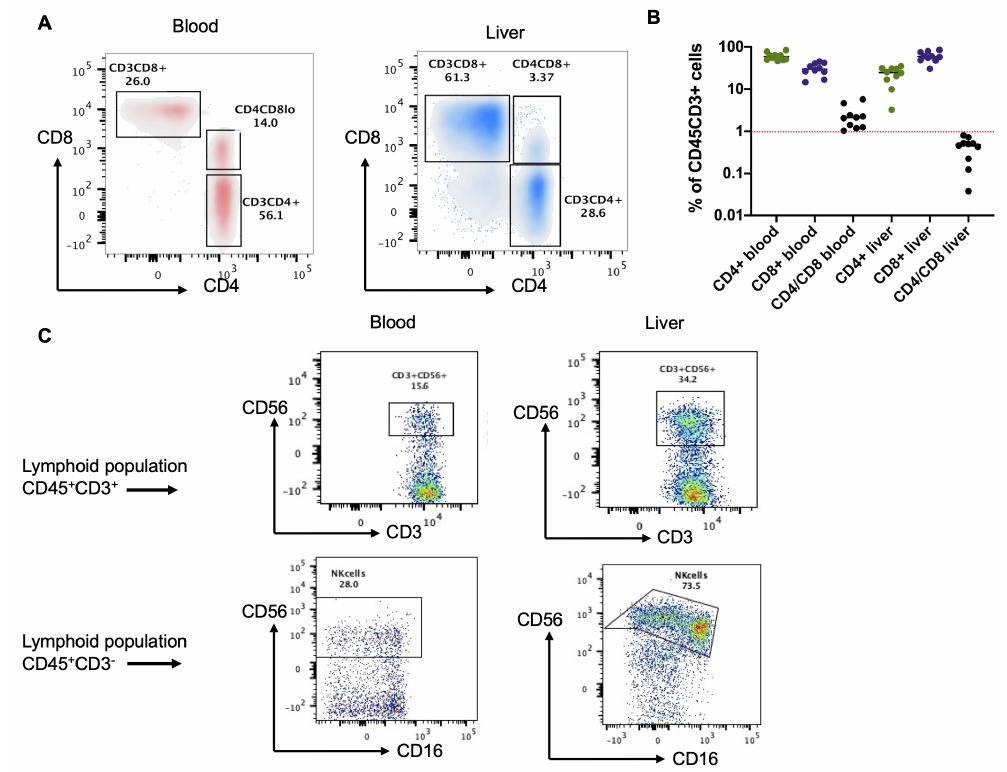
Figure 2. Characterization of lymphoid T cell population in whole blood and liver samples from the FIBROTHER study ( n = 10). A flow cytometry analysis was performed to characterize the different immune cell types, and the sources of IL-17A in human whole blood and liver samples. ( A ) The main characteristic of immune cells infiltrating the liver is the preponderance of the CD3CD8 + population over the CD3CD4 + . ( B ) The representative graph shows the total distribution of these populations and the CD4/CD8 ratio, i.e., >1 in the blood and <1 in the liver. The graph is representative of a total n = 10. ( C ) The liver contains more of the CD45 + CD3 − CD56 + and CD45 + CD3 + CD56 + CD16 +/ − cell populations than blood, corresponding to NK cells,